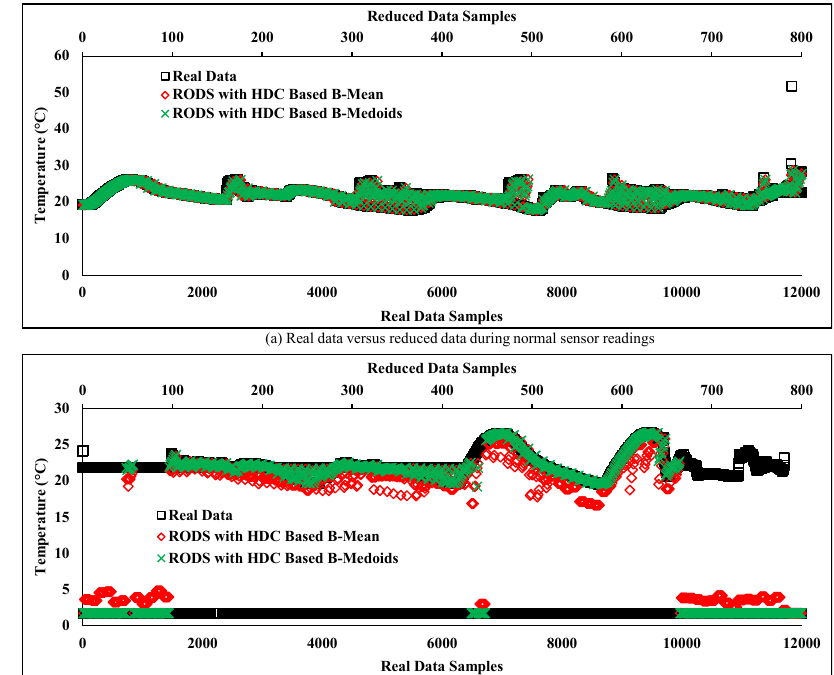
Figure 16. Performance comparison of real normal and noisy data with reduced data using the proposed RODS with HDC-based technique versus time. ( a ) Temperature versus real normal and reduced data based on the proposed RODS with HDC-based technique; ( b ) temperature versus real noisy and reduced data based on the proposed RODS with HDC-based